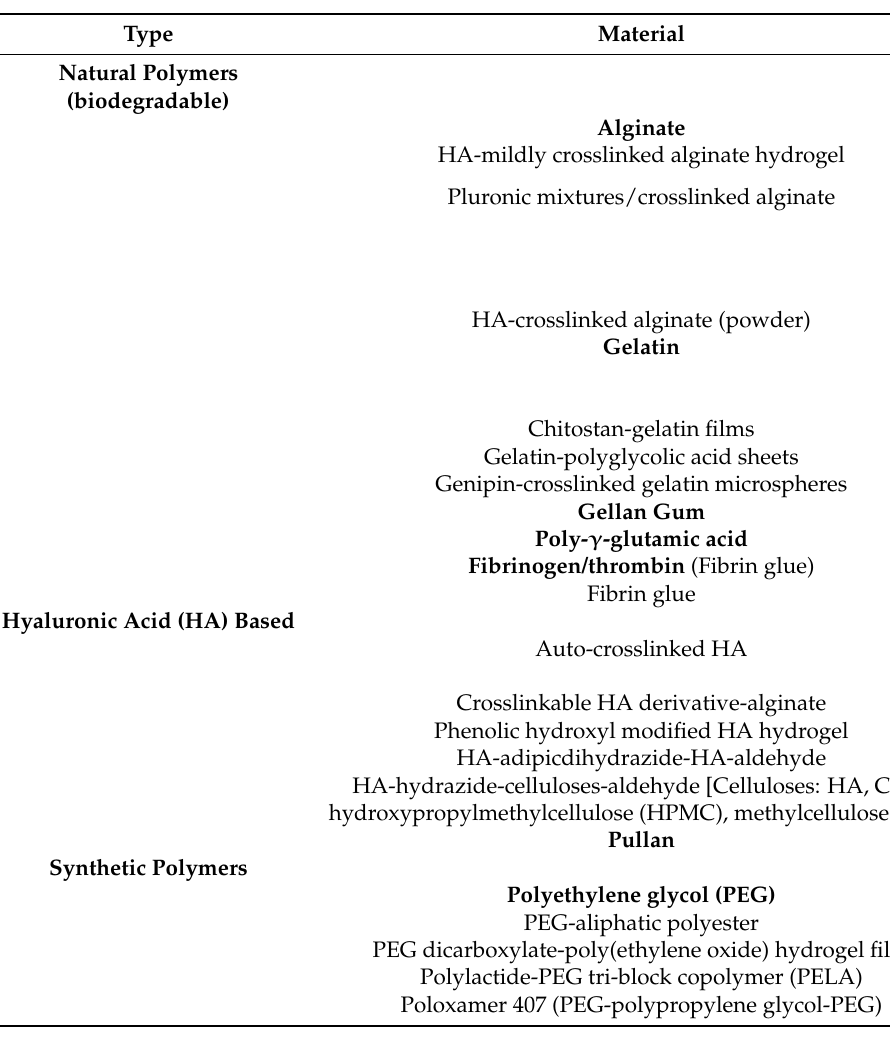
Table 3. Materials demonstrating efficacy in human or animal models as per clinical indication of anti-adhesion